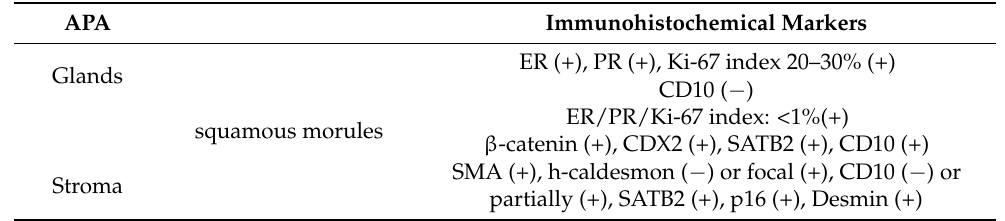
Table 4. Immunohistochemical features of APA. APA Immunohistochemical Markers